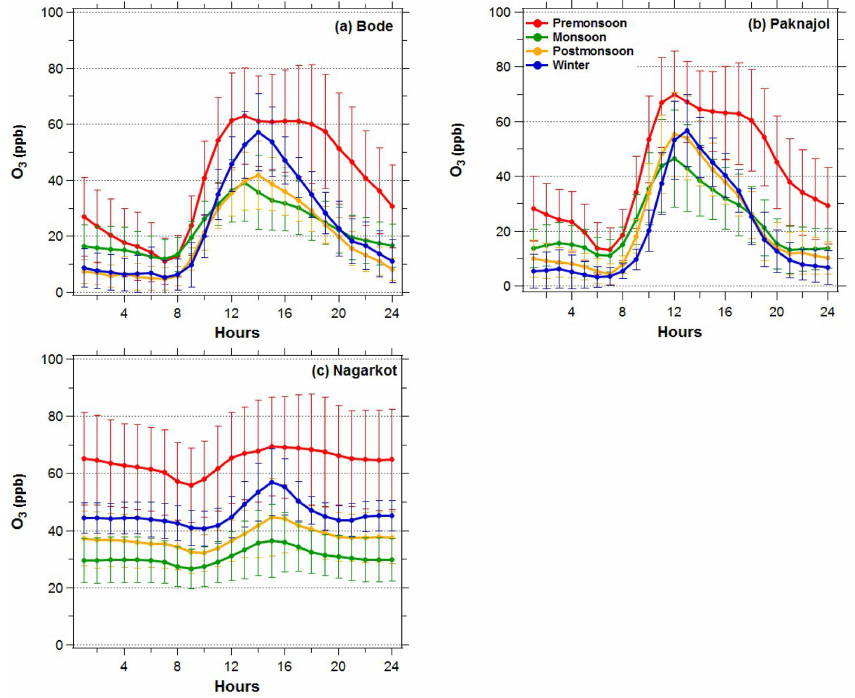
Figure 7. Diurnal pattern of hourly average O 3 mixing ratio for different seasons during January 2013–January 2014 at (a) Bode, (b) Paknajol and (c) Nagarkot in the Kathmandu Valley. The four seasons (described in the text) are defined as premonsoon (March–May), monsoon (June–September), postmonsoon (October–November) and winter